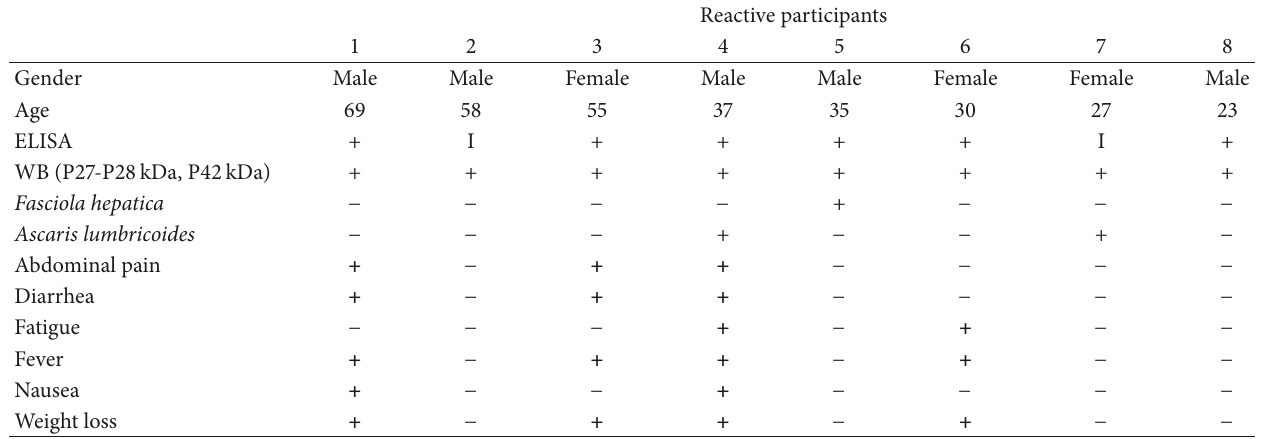
Table 2: Test results and symptoms reported by participants with reactive